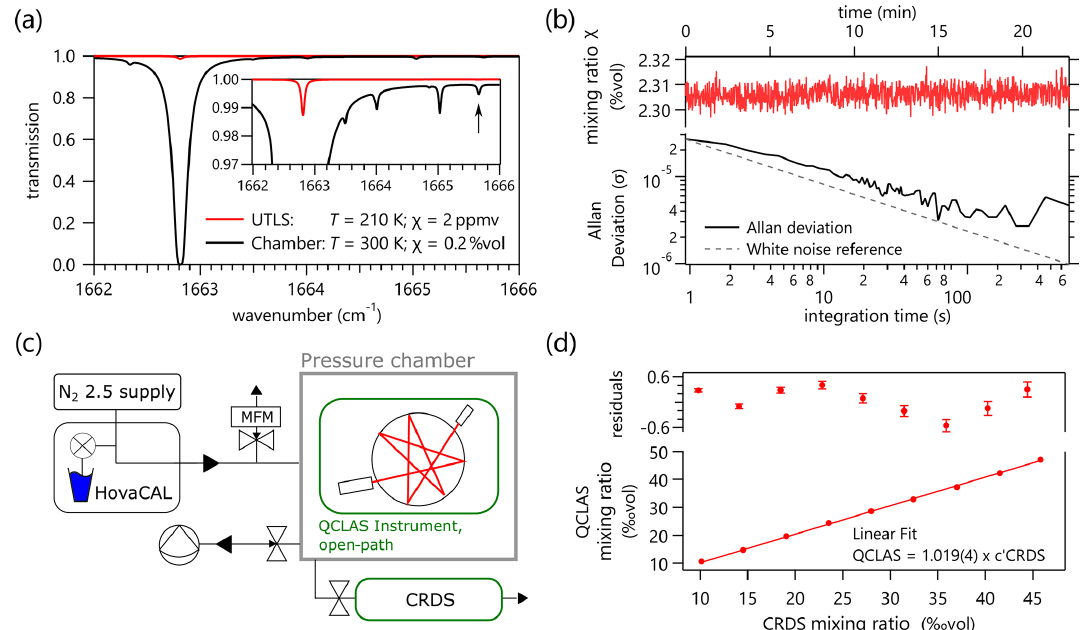
Figure 6. (a) Absorption lines in the vicinity of the one selected for UTLS measurements are about 3 orders of magnitude weaker, which renders them a representative alternative for measurements at high H 2 O concentration. (b) Allan–Werle deviation plot at 259hPa for an absorbance representative of the UTLS. A relative Allan deviation of 0.11% at 1Hz is found, showing further enhancement upon longer averaging times. (c) The laboratory-based setup for open-path instrument characterization. (d) Direct comparison of the calibration-free QCLAS results with a calibrated CRDS system at 253hPa, showing excellent agreement with a coefficient of determination of R 2 = 0 .